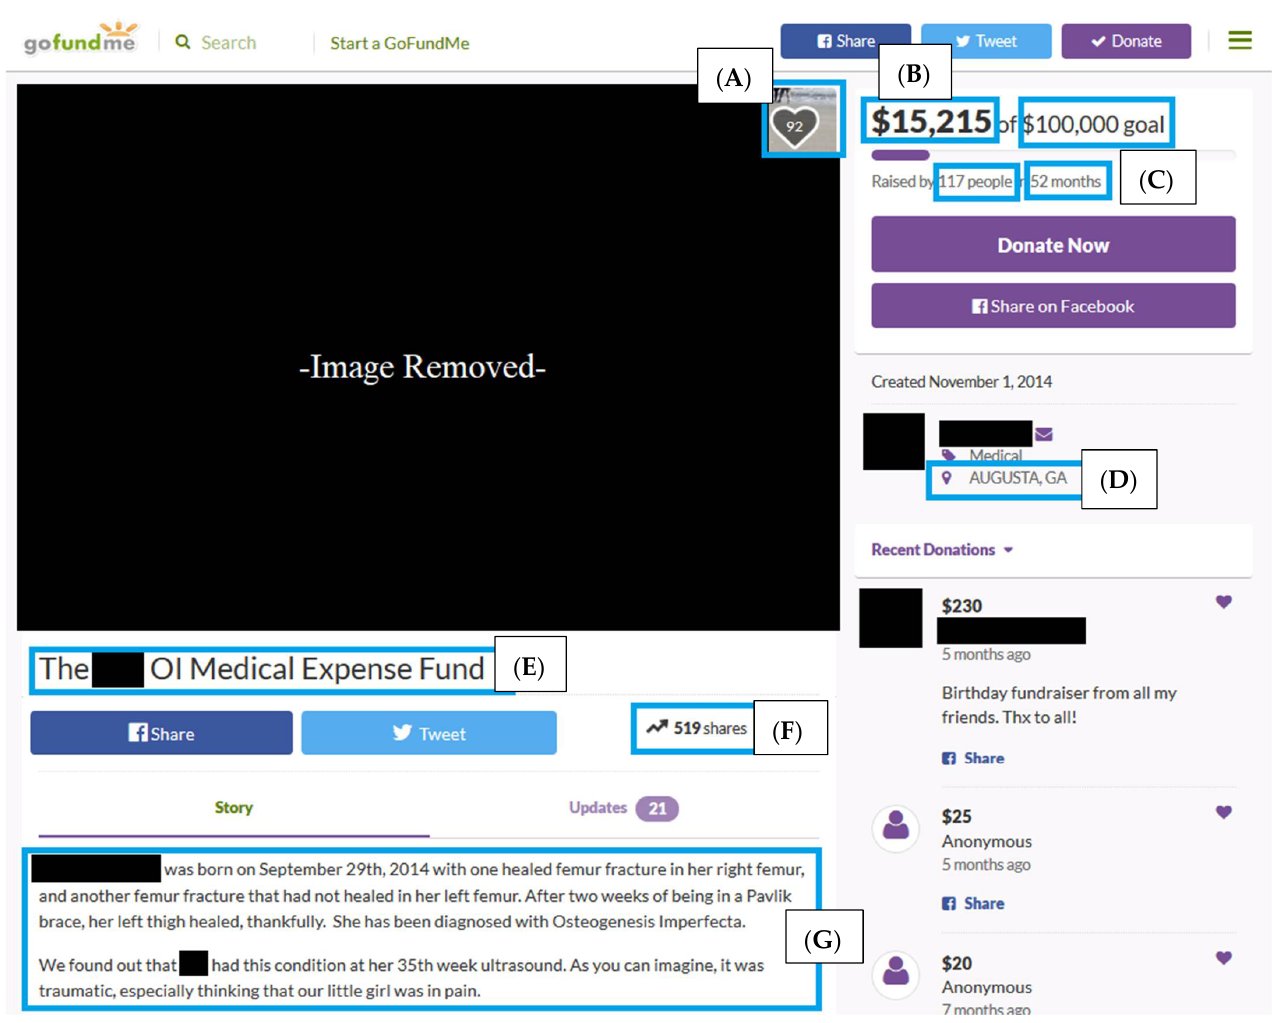
Figure 1. Sample of a GoFundMe ® Webpage Anonymously Displayed. ( A ) = number of “likes” by viewers; ( B ) = amount of money raised out of the total funding goal; ( C ) = number of people that have donated over a period of time; ( D ) = location of the profile creator; ( E ) = title of the webpage; ( F ) = number of times the webpage has been shared by other users/viewers; ( G ) = backstory behind the creation of the webpage.